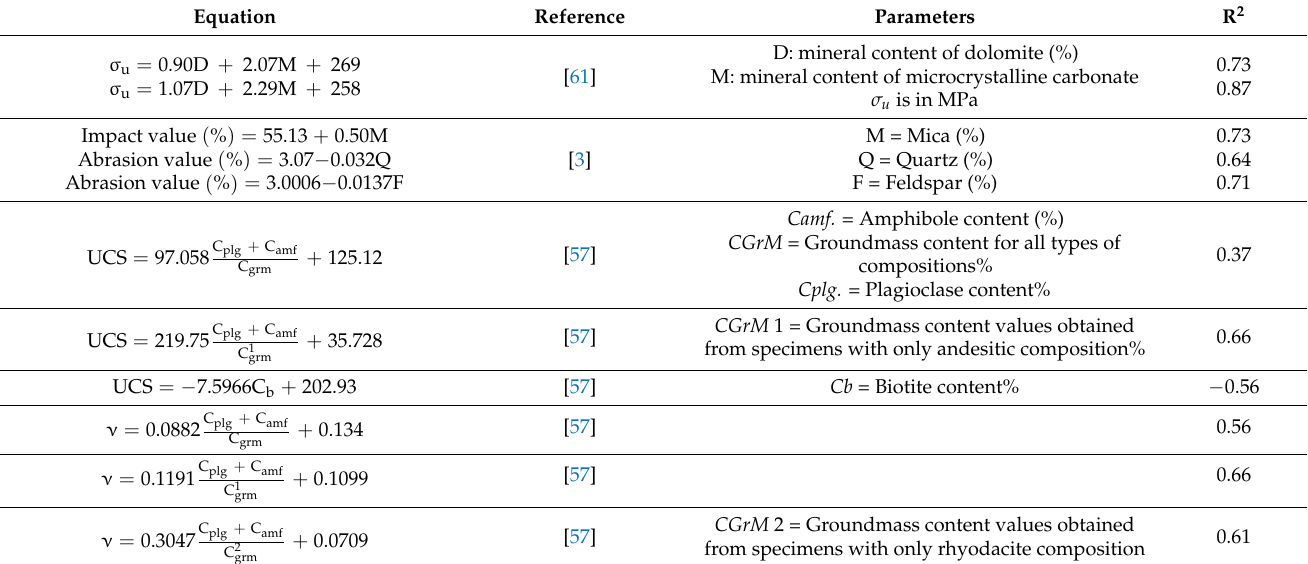
Table 11. Regression equations between mechanical properties and some aspects of rock texture characteristics.